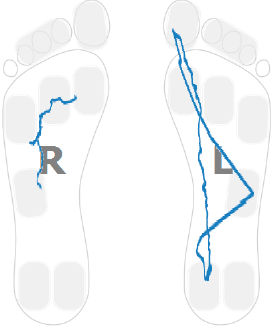
Figure 9. Post-stroke survivor pressure patterns.